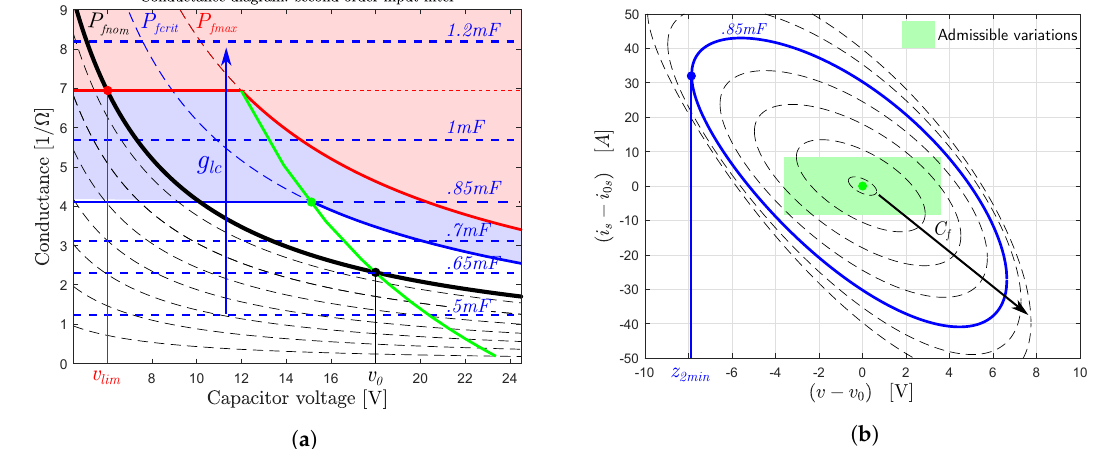
Figure 9. Design example: diagrams ( a ) of conductance and ( b ) of invariant region for second-order filter with variable filter capacitor C f and fixed f c = 1 kHz and P f = 750 W. To illustrate the selection procedure, variations up to ± 20% for both voltage v and current i s , are considered admissible for the normal operation of the power module (represented by the green area Figure